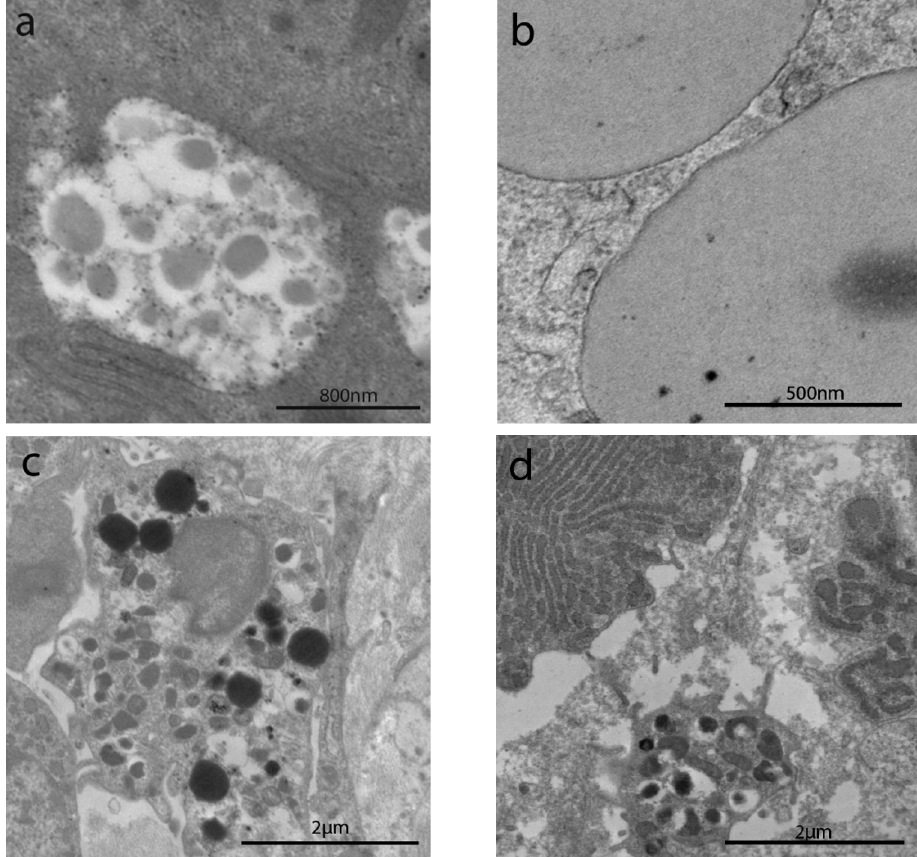
Figure 6. TEM images of chylomicrons, lipid droplets, and mast cells in IBS-like disorders. Chylomicrons in WA ( a ); lipid drops in NCGS and Ni ACM ( b ), mast cells in uCD, WA ( c ), and Ni ACM ( d ).